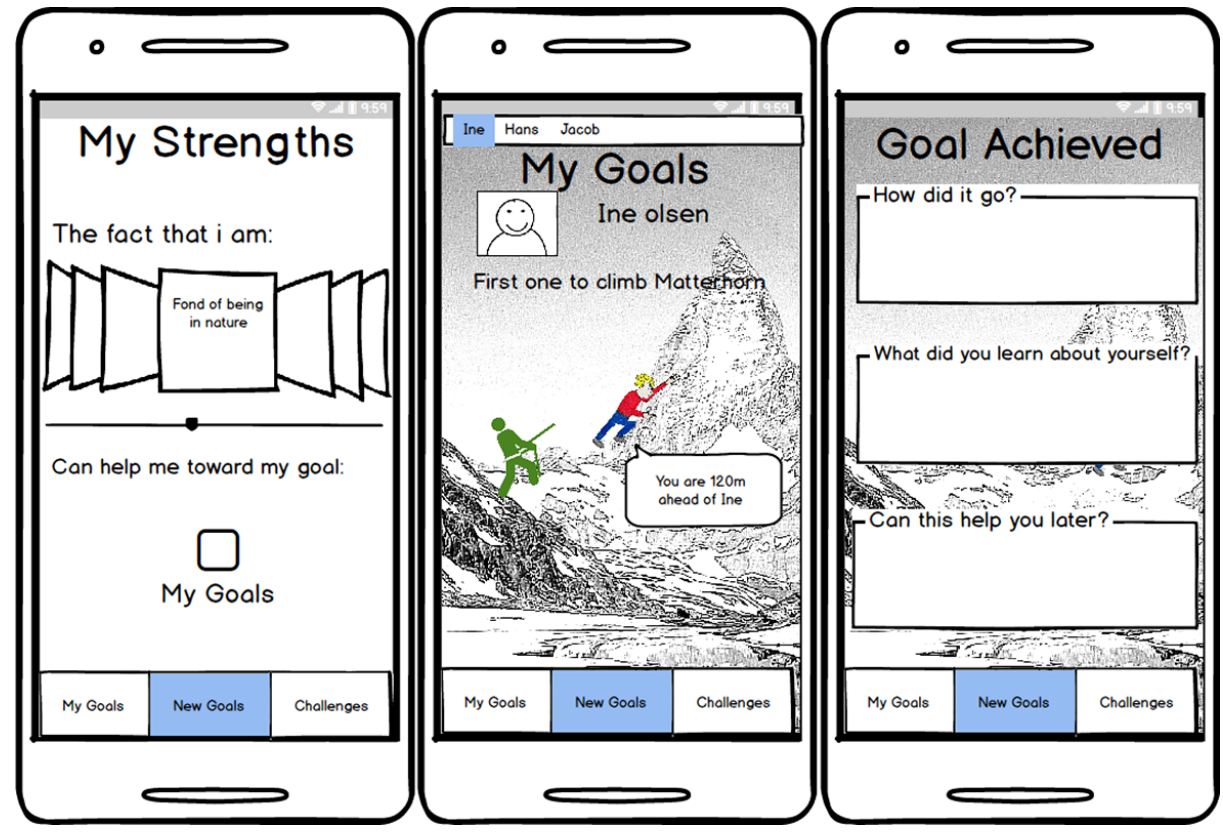
Figure 5. Paper prototypes for workshop